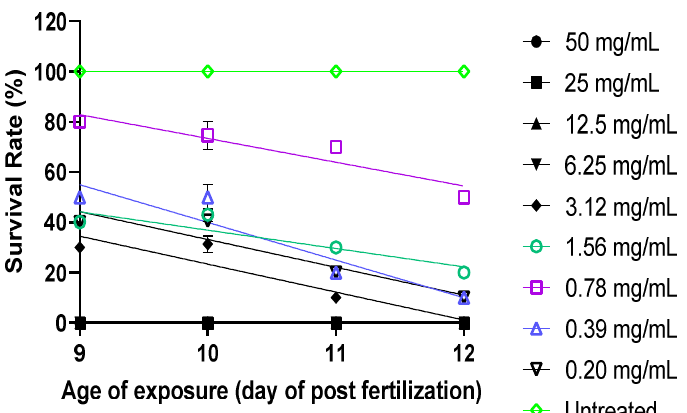
Figure 5. Survival rate of zebrafish larvae (9 to 12 dpf) exposed to TNBS at two-fold serial dilution (0.2–50 mg/mL). Zebrafish larvae at 12 dpf survived (>60%) in TNBS at concentration <0.78 mg/mL .